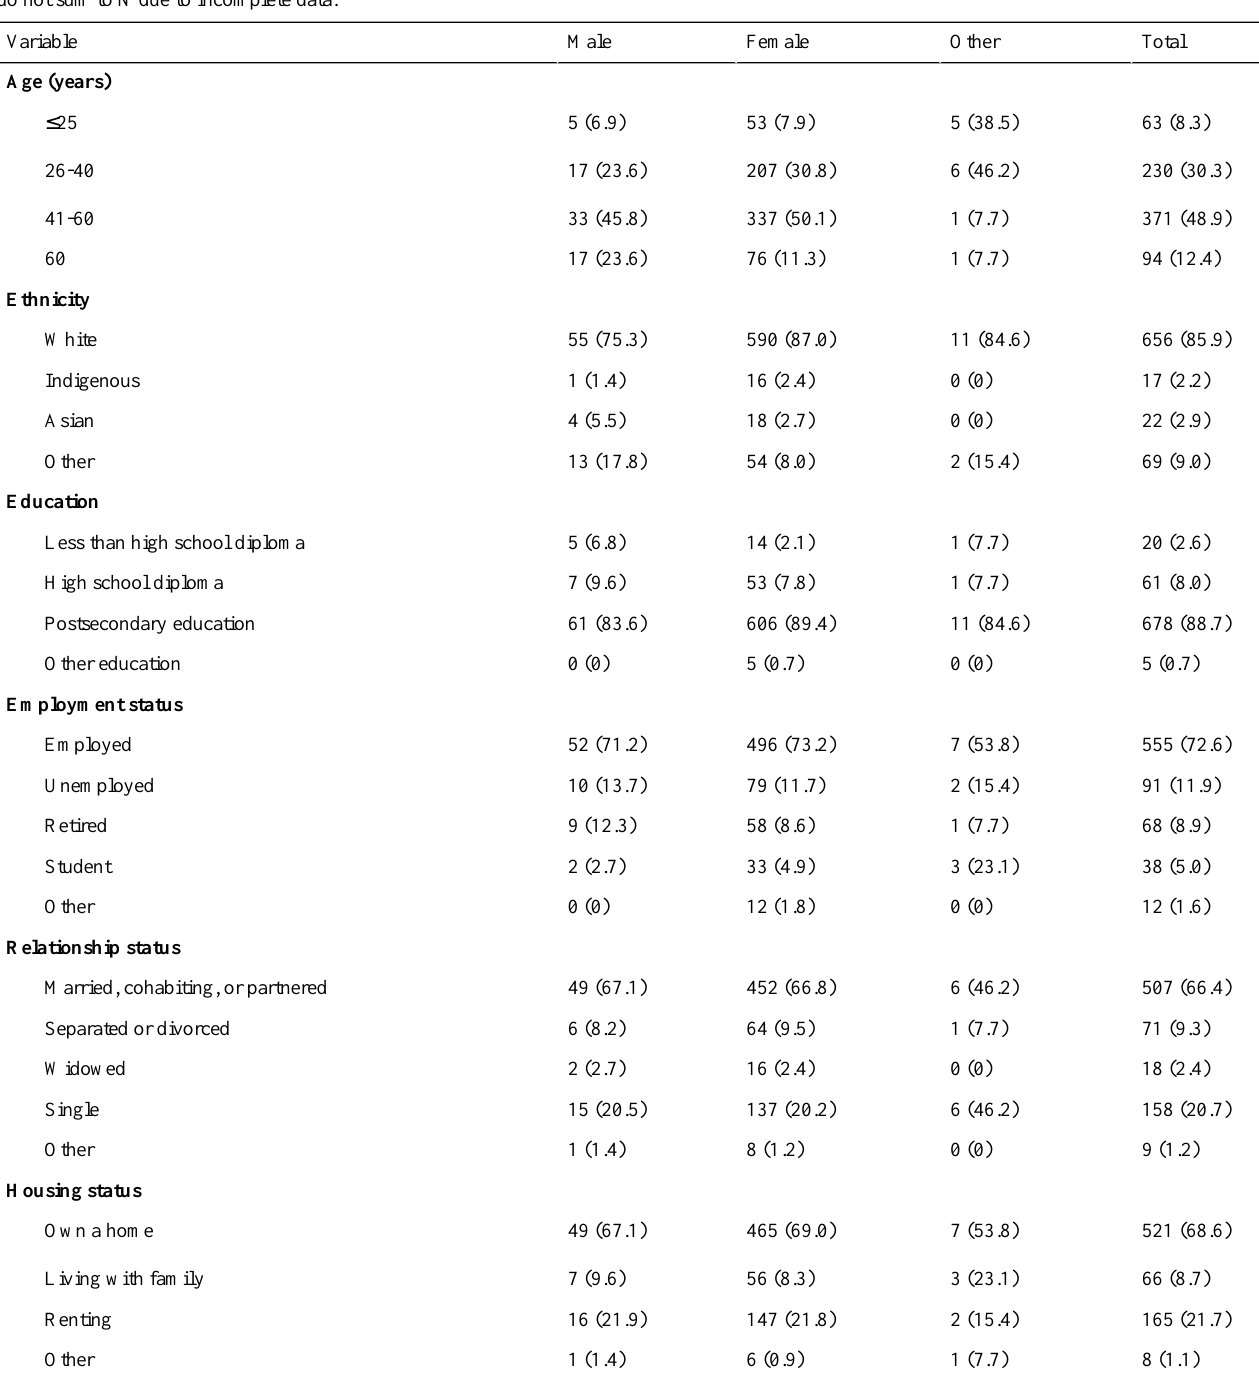
Table 1. Demographic characteristics of respondents who completed both surveys by identified gender (N=766), n (%). Note that some category totals do not sum to N due to incomplete